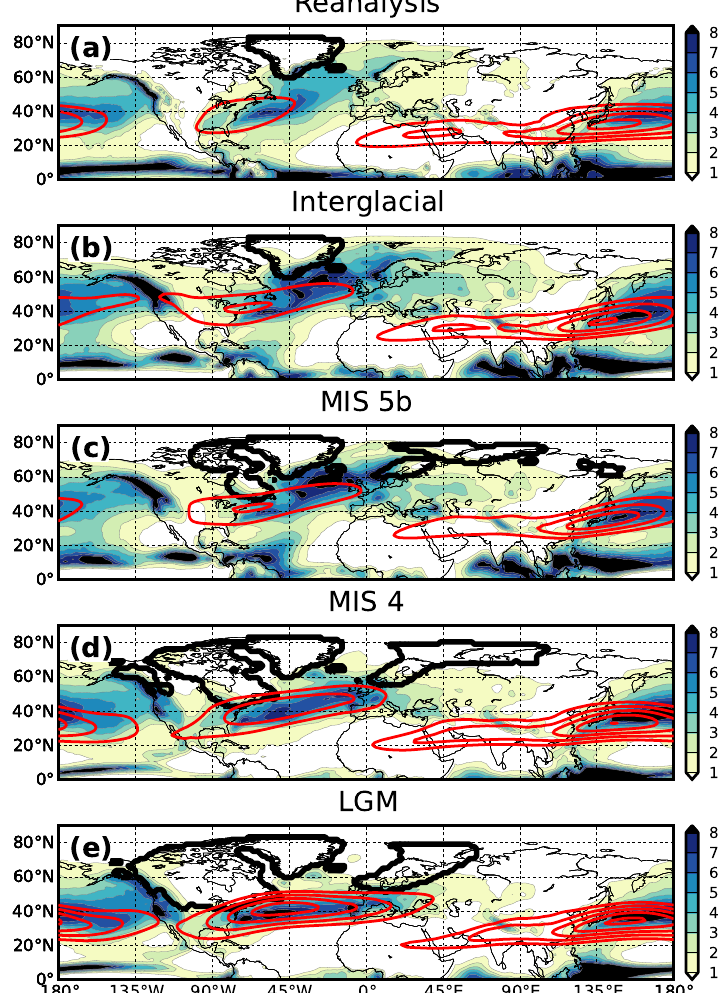
Figure 4. Evolution of the winter (DJF) precipitation (mmday − 1 ) over the glacial cycle. The ice sheets are indicated by the heavy black contours and the red contour lines show the 300hPa zonal wind speed (10ms − 1 contours starting at 30ms − 1